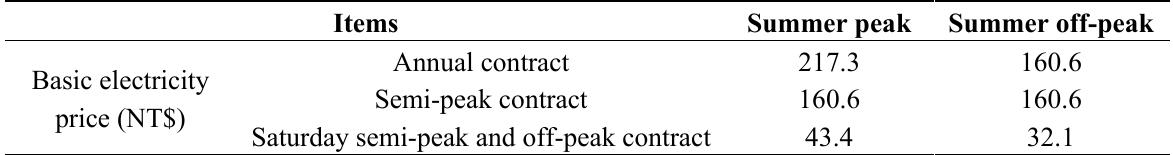
Table 7. Contract capacity rate signed by August 2006.